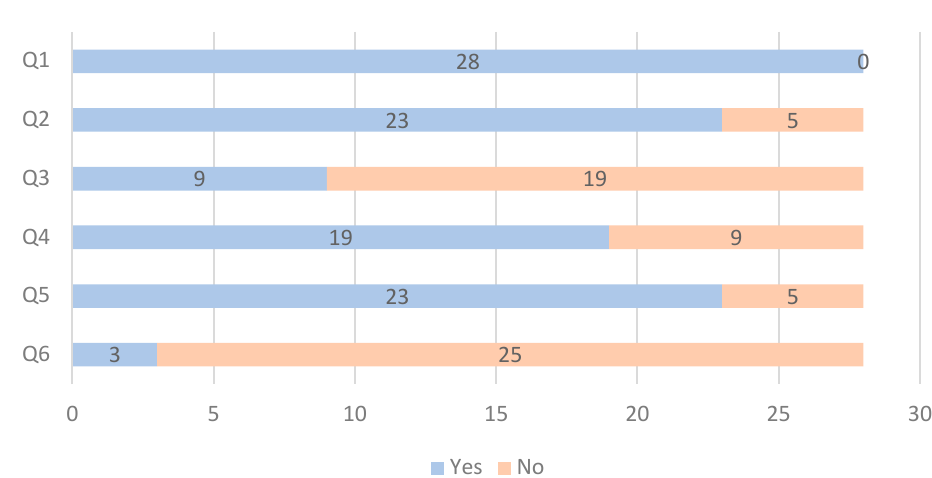
Table 2. Study quality assessment questions.